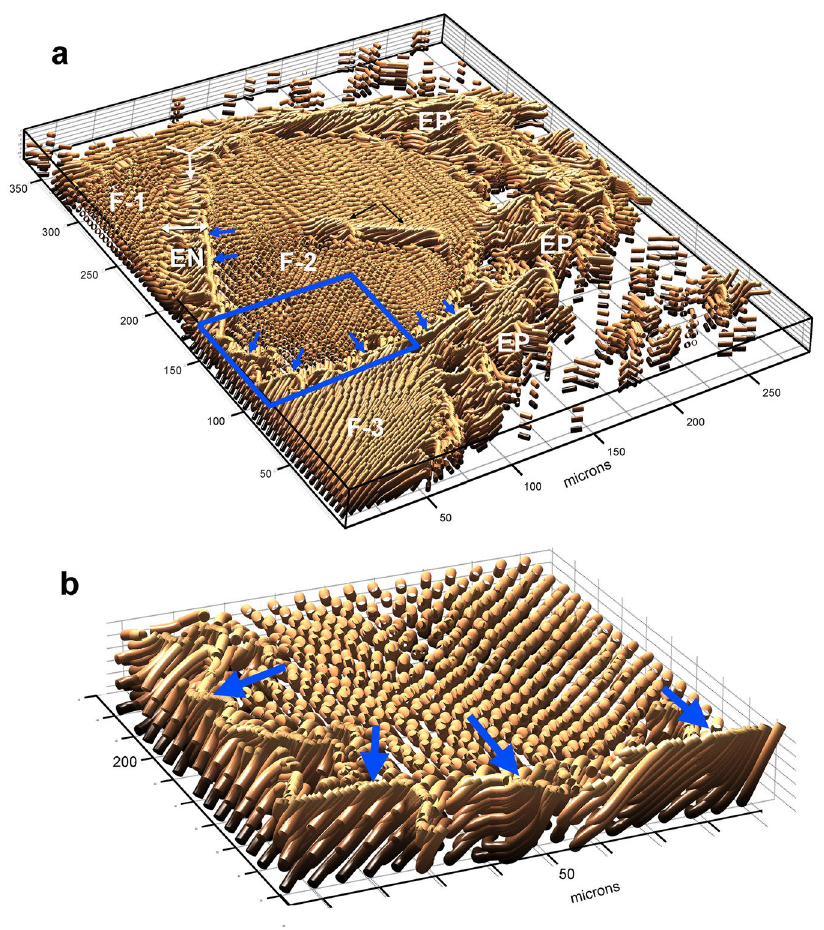
Figure 4. SHARP image of tendon cross-section, rendered using both in-plane and out-of-plane orientation data: ( a ) SHARP image of the sample in Fig. 3 clearly reveals the morphological differences between the ordered fascicles and the woven pattern of the epitenon and endotenon. The presence of two fascicles in the lower compartment is confirmed by the presence of the visceral paratenon, indicated by blue arrows, that separates them. The collagen bundles in the largest fascicle (F-2) show a gradual change in out-of-plane orientation, an indication of skewed crimp; ( b ) Detailed view of the visceral paratenon (see blue box in panel a), characterized by axially oriented, parallel fibrils that form a very thin wall enclosing the fascicles. Legend: EN = endotenon, EP = epitenon, VP = visceral paratenon, F-1, F-2, F-3 = three separate